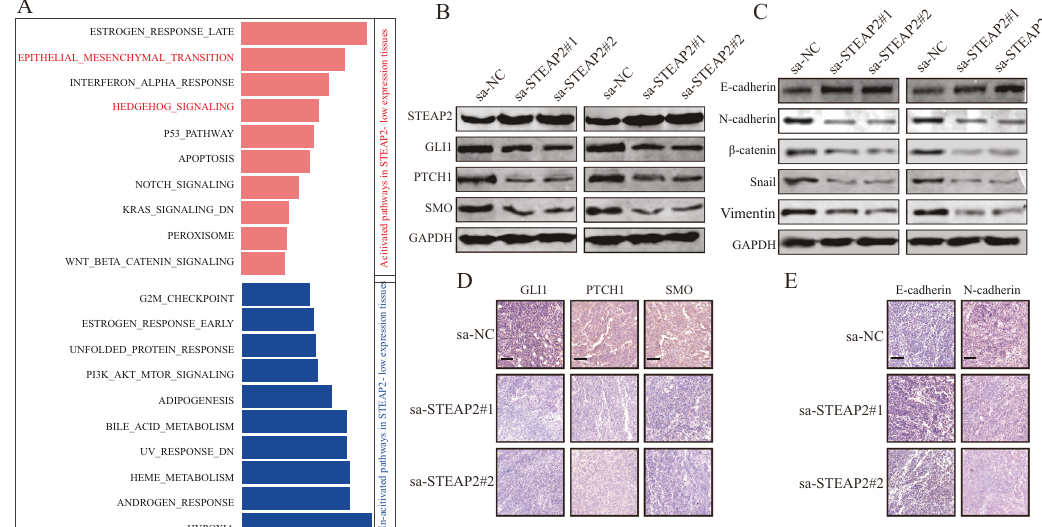
Fig. 5 STEAP2 inhibit PTC progression through blocking hedgehog signaling pathway and EMT. A GSVA analysis showed that hedgehog signaling pathway and EMT in PTC with STEAP2-low expression compared with those with STEAP2-high expression was identi fi ed as the top three activation pathways based on TCGA analysis (red bar: acitivated pathways in STEAP2- low expression tissues; blue bar: In-citivated pathways in STEAP2- low expression tissues). B Effect of STEAP2 activation on the expression of Hedgehog signaling pathway-related proteins (SMO, Gli1, and PTCH1) in PTC cells. C Representative western blots showing changes in EMT markers (E-cadherin, N-cadherin, snail, vimentin, and β -catenin) in PTC cells after STEAP2 activation. Protein expression levels of Hedgehog signaling pathway-related proteins (Smo, Gli1 and PTCH1) ( D ) and the EMT markers (E-cadherin and N-cadherin) ( E ) in xenograft tumors were determined by IHC. All data are presented as the mean ± standard deviation of three independent experiments. * P < 0.05, ** P < 0.01, and *** P < 0.001.